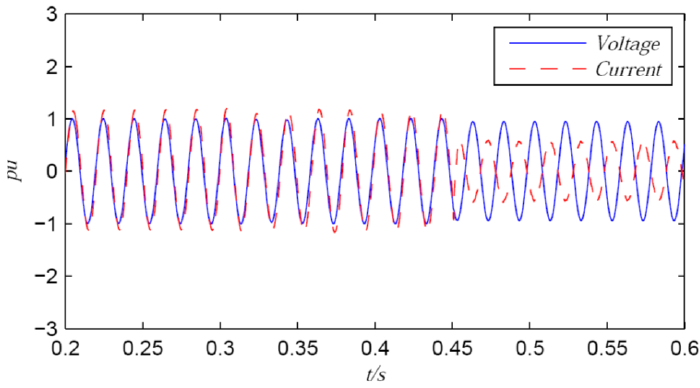
Figure 11. Single ‐ phase voltage and current output by refined controller.